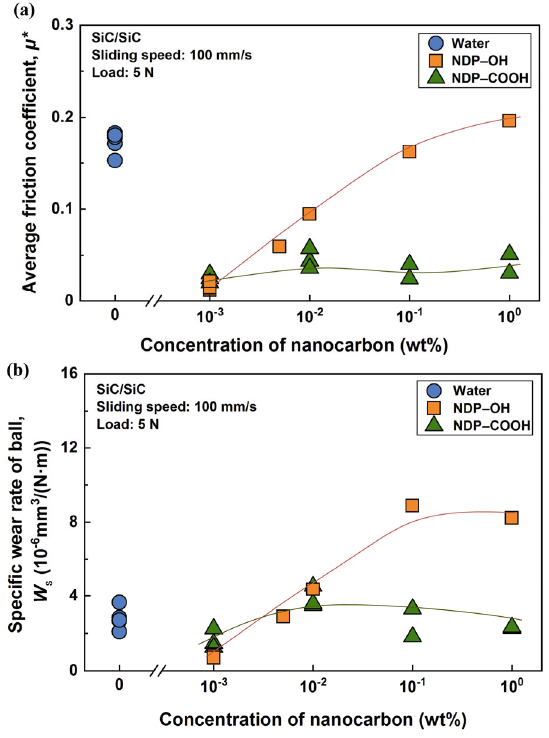
Fig. 7 Effect of concentration and terminations of NDPs on (a) average friction coefficient and (b) specific wear rate of the ball.